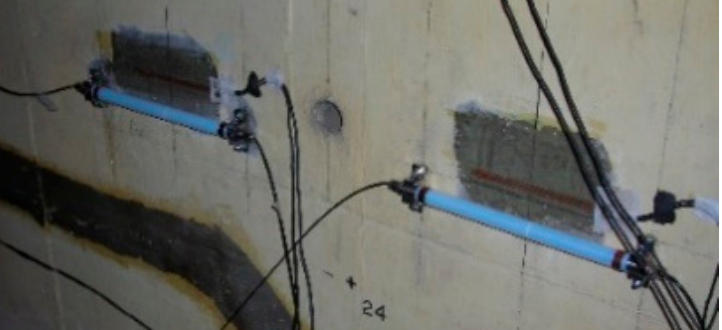
Figure 2. Mumbai railway bridge.